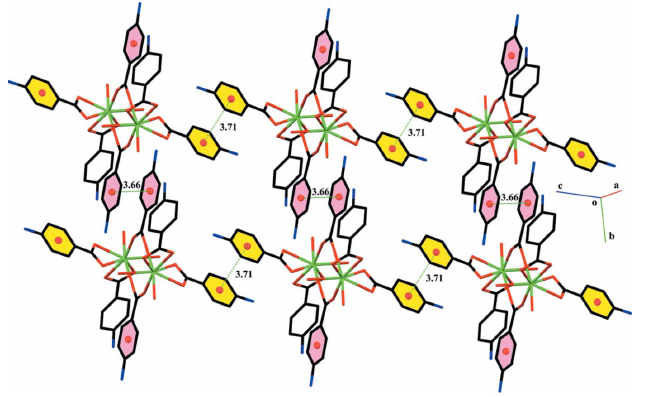
Figure 4 Graphical representation of off-set (cid:2) – (cid:2) interactions in 4ABA-Tm . H atoms and water molecules are not shown for simplicity.